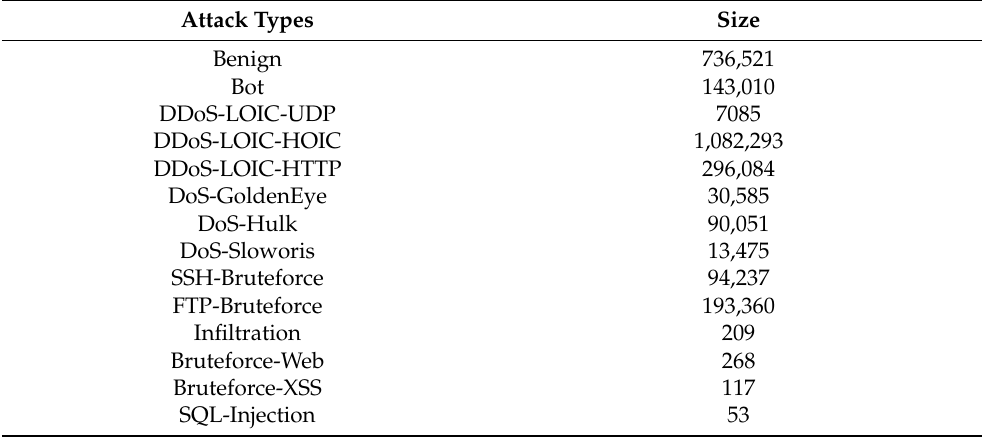
Table 1. CSE-CIC-IDS 2018 dataset.